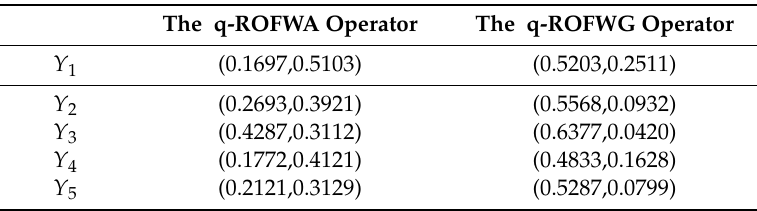
Table 6. The fused results of Y i ( i = 1,2,3,4,5 ) . The q-ROFWA Operator